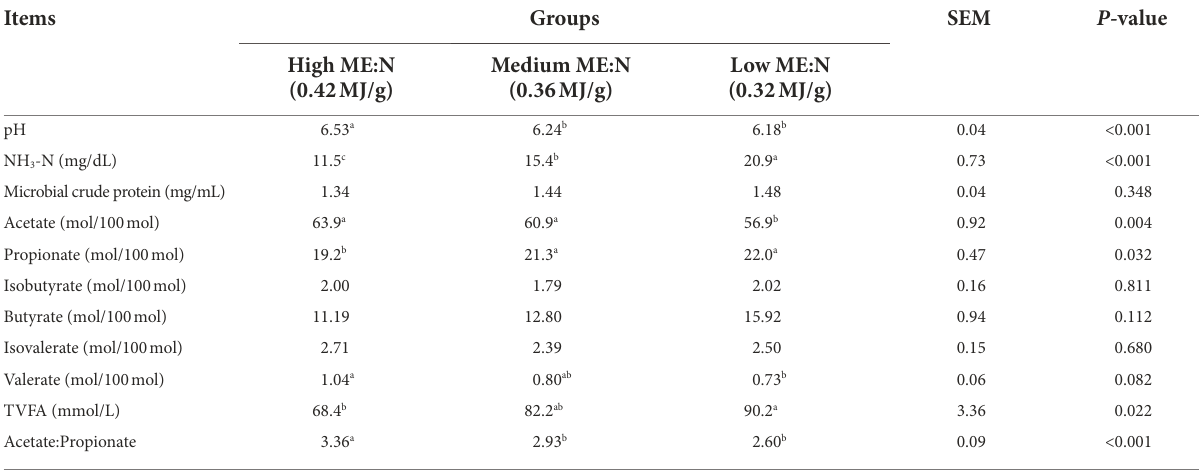
TABLE 3 Effect of dietary ME:N ratio on rumen fermentation parameters in yaks. Items